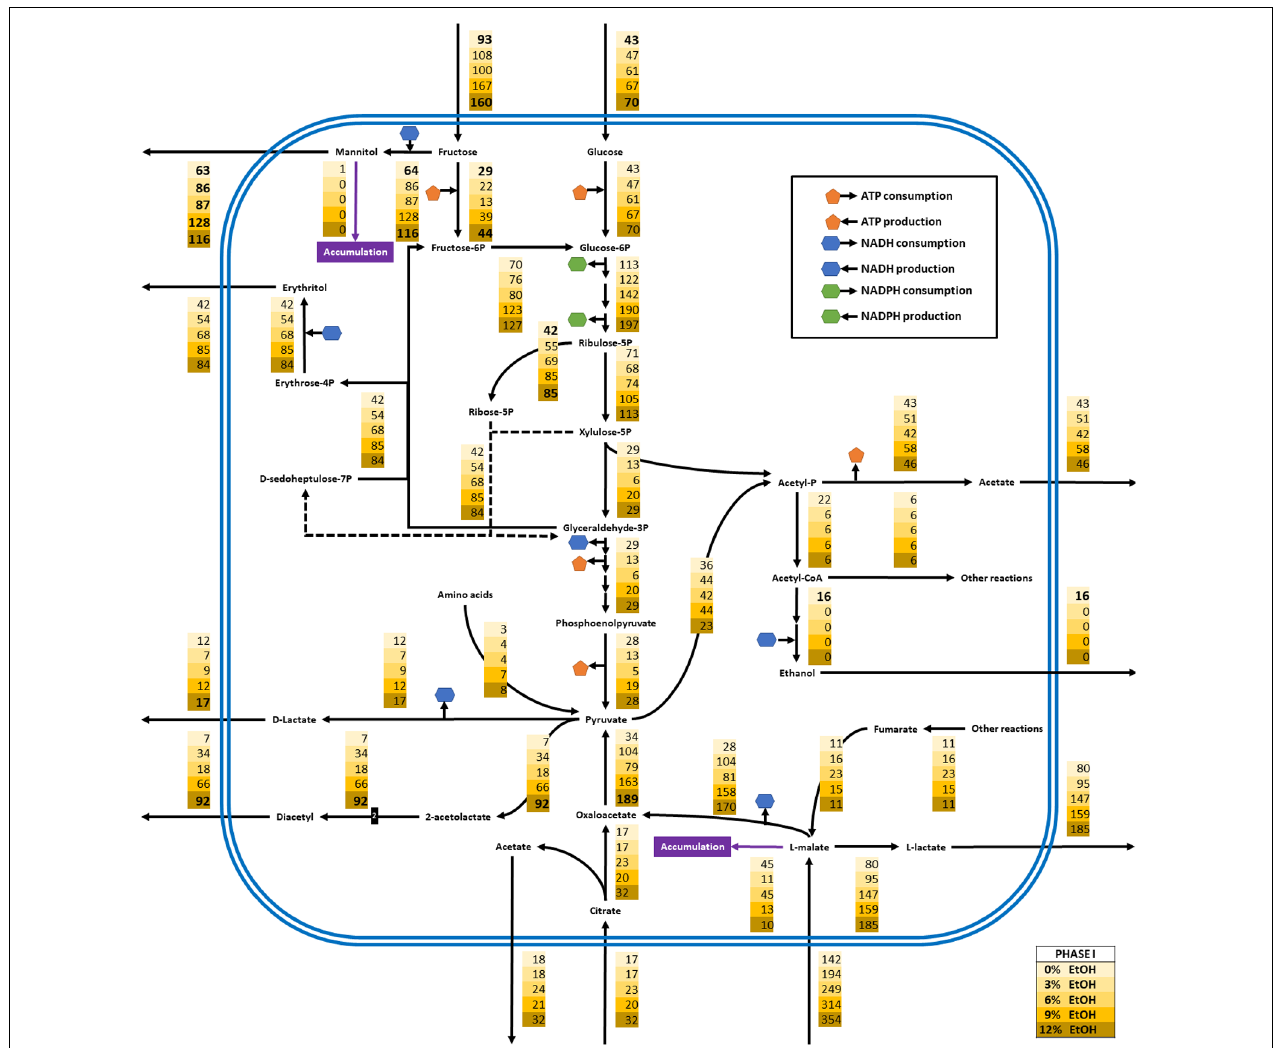
FIGURE 7 | Metabolic flux redistribution of the central carbon metabolic pathways of O. oeni PSU-1 upon cultivation in a culture medium without and with 3, 6, 9, and 12% (yellow boxes, from top to bottom) ethanol concentration, during growth phase I. Polygons with colors orange, blue and green indicate consumption (or production) of ATP, NADH and NADPH,